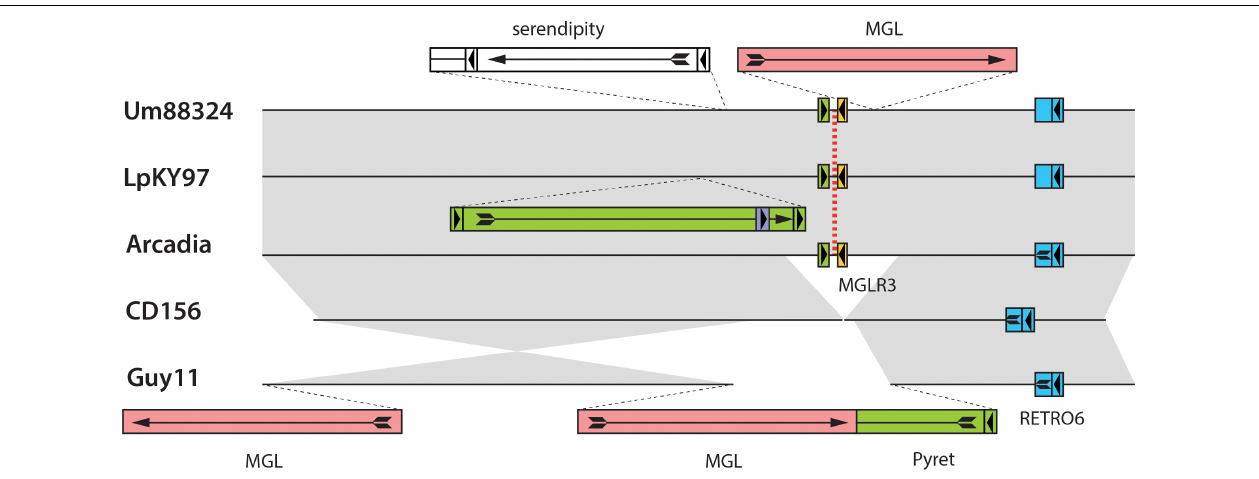
B , C All deleted in single rearrangement event. D Present on chromosome 4. E Motifs in boldface text are the vestigial telomeres at the 3’ ends of the MoTeR relics.